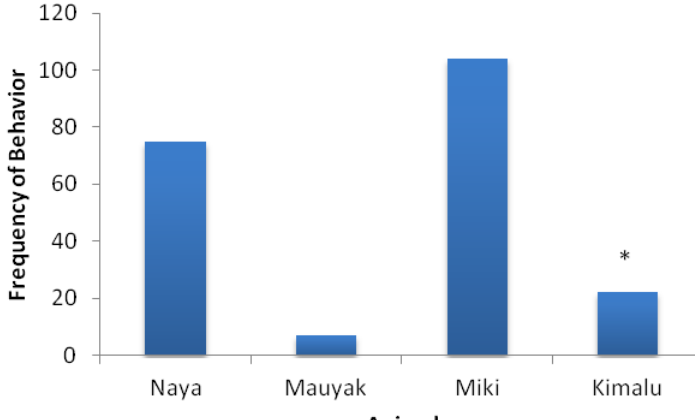
Figure 2. Frequency of bubble play behaviors for each beluga. *Kimalu’s bubble helix play behaviors were typically approximations of the behaviors he observed.